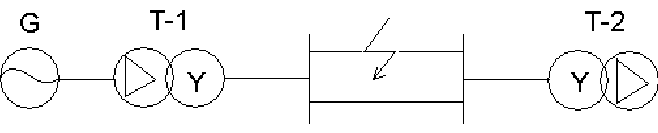
Figure 3. The topology network of the SMIB system.